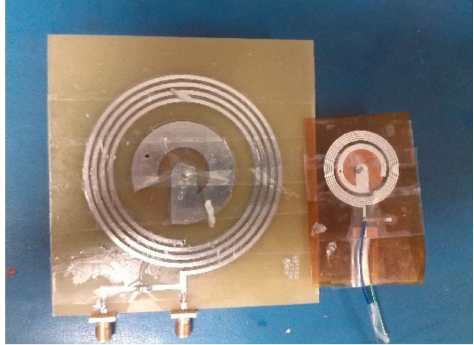
Figure 6. The fabricated prototype of the EX (left) and IM (right).